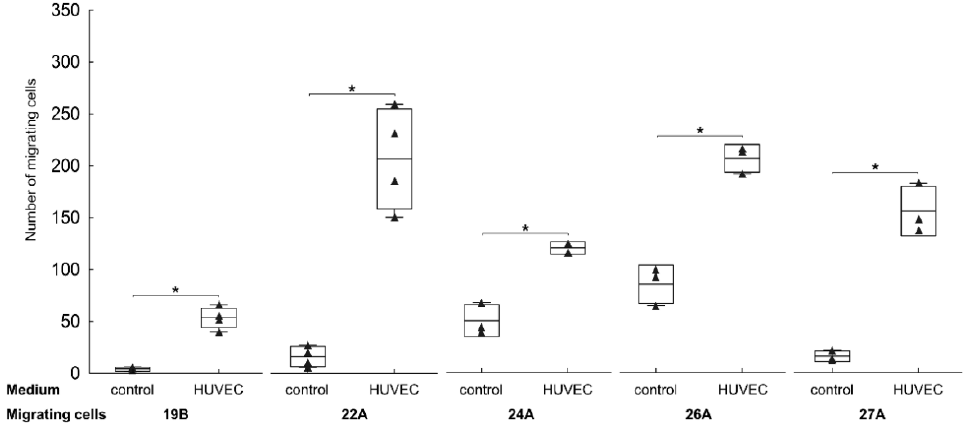
Figure 3. FAP + mesenchymal cells are attracted by endothelial cells in vitro. Chemotaxis of FAP + mesenchymal cell cultures (19B, 22A, 24A, 26A, 27A) towards control (non-conditioned) medium and to human umbilical vein endothelial cell (HUVEC)-conditioned medium. The media were supplemented with 1% foetal calf serum. Cell migration was evaluated using a modified Boyden transwell migration assay after 24 h. Results are presented as average number of migrating cells, for cell culture 19B one representative experiment of two is shown, for 22A, 24A, 26A and 27A one experiment was performed in at least triplicates depending on cell availability. * p < 0.05 compared to the corresponding control, Welsch ’ s t -test. Line — mean, box — mean ± SD, whiskers — range, triangles — raw data.